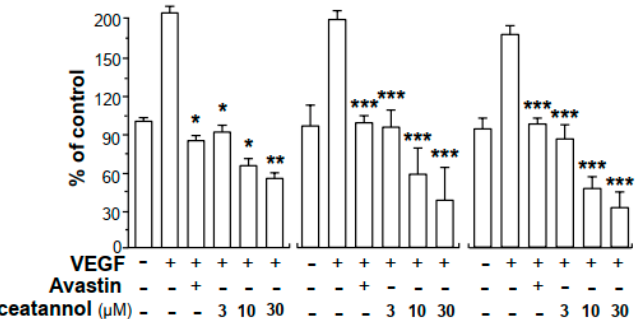
Figure 2. Piceatannol inhibits VEGF-mediated endothelial cell migration, cell invasion and tube formation. In cell migration assay, HUEVCs, at a density of 2 × 10 5 / well were seeded into each well of a sterile 12-well plate. A wound located in the middle of cell monolayer was made manually. Pictures representing wounds were taken separately at 0 h and 8 h by using a phase-contrast microscope. Cells were treated with VEGF in the presence or absence of piceatannol. In cell invasion assay, 100 µ L of cell cultures suspended in fresh medium was plated onto the upper part of chamber of a piece of a 12-well Transwell plate. In the upper compartment, cells were treated by VEGF with or without piceatannol. In the lower chambers, 500 µ L fresh medium was applied. Drug application lasted for 24 h, and cells invaded into the lower chambers were analyzed and quantified by counting cell numbers manually after fixation. In tube formation assay, each well of a 24-well plate was precoated with Matrigel and 1 × 10 5 endothelial cells were seeded. Cell suspension was incubated with VEGF with or without piceatannol, and the drug treatment lasted for 8 h. Images representing cell tube-like structures were photographed under a phase-contrast microscope. To perform the quantification of pictures, three fields in one picture were randomly determined and formed branching points were analyzed and counted manually. In all cases, VEGF was used at 10 ng / mL. Avastin (200 µ g / mL) served as a positive control. Data expressed as mean ± SEM of the percentage of control group, where n = 3; p < 0.05 (*); p < 0.01 (**); p < 0.001 (***) vs. VEGF-treated group. Bar = 40 µm.